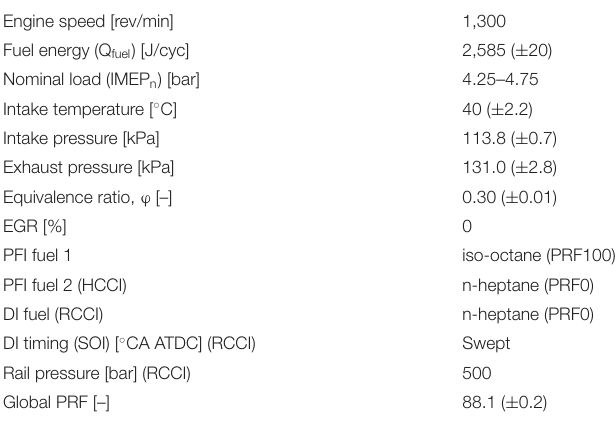
TABLE 3 | Engine operating conditions of PRF HCCI and RCCI experiments. TABLE 4 | Approximate experimental measurement